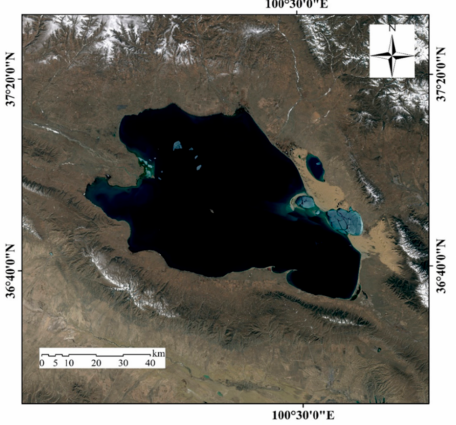
Figure 1. Location of Lake Qinghai. The true color image is created from a remote sensing image acquired on 17 April 2019 from Landsat 8 Operational Land Imager